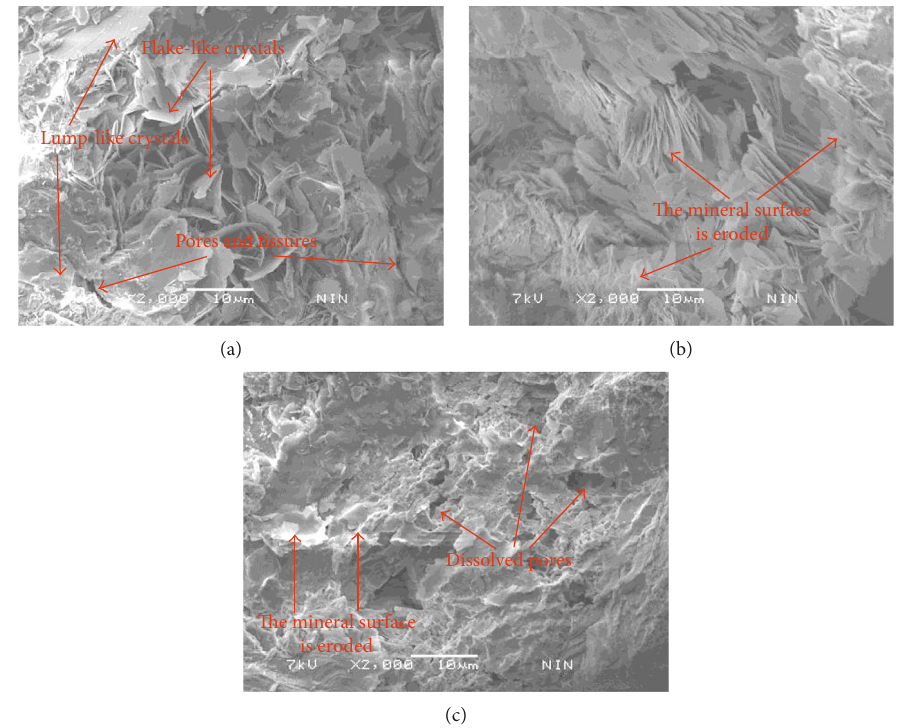
Figure 11: SEM images of the sandstone samples attacked by pH � 3 H soaked in sulfuric acid solution at pH � 3 for (b) 30 days and (c) 90 days.